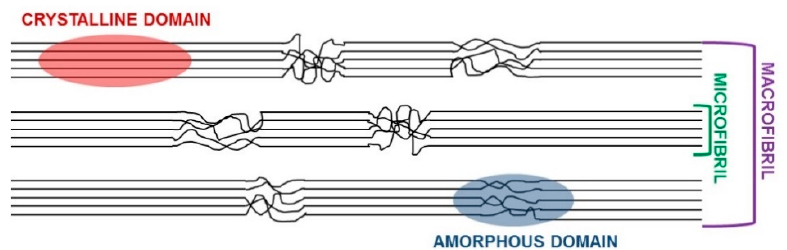
Figure 2. Cellulose fibrils in CI. Highly-ordered regions (crystalline domain) and disordered regions (amorphous domain) are shown.